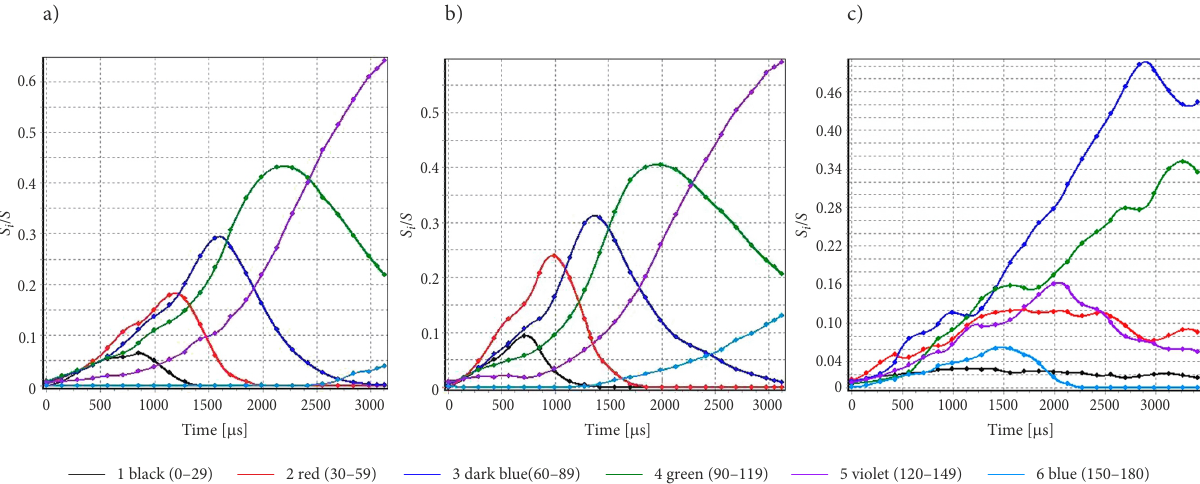
Figure 4. The structure of the fuel jet: a – CR system (60 MPa); b – CR system (100 MPa); c – CDS system (26°C, 1750 min –1